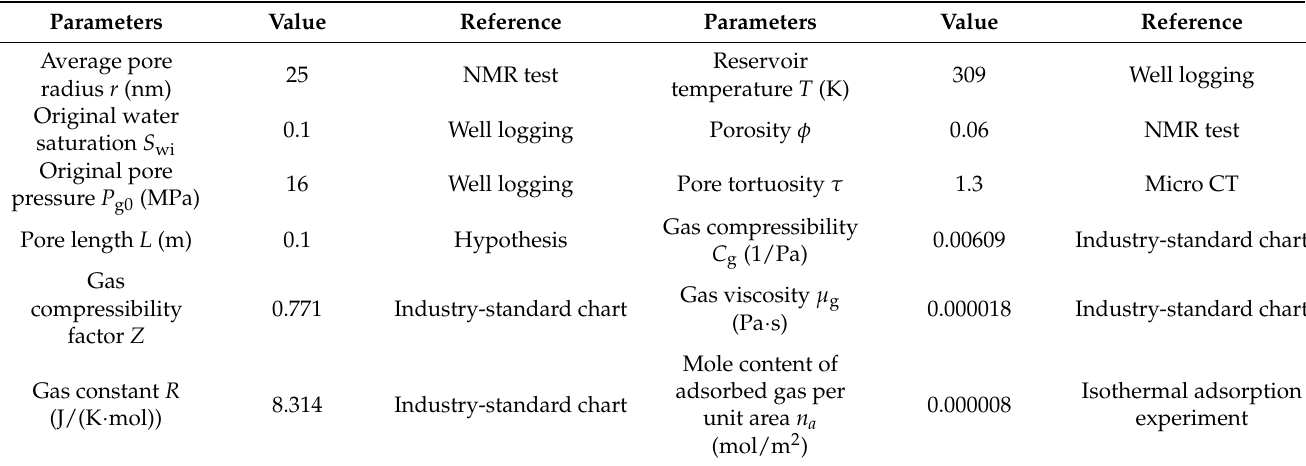
Table 2. Relevant parameters used for each model calculation.